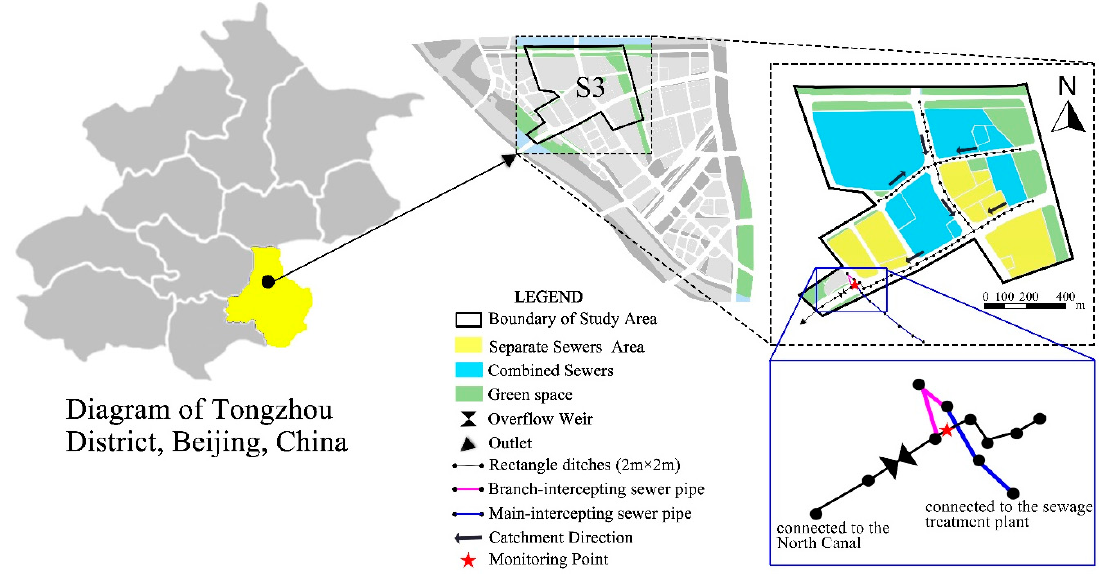
Figure 1. General situations of the study area.